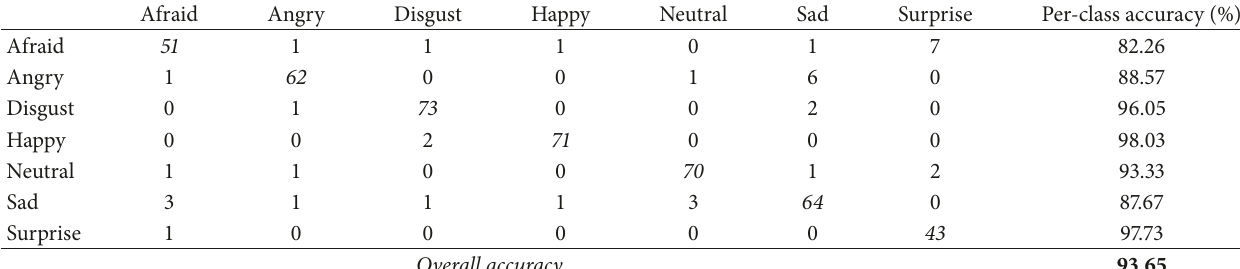
Table 3: Confusion matrix and overall accuracy for the test set of KDEF dataset.